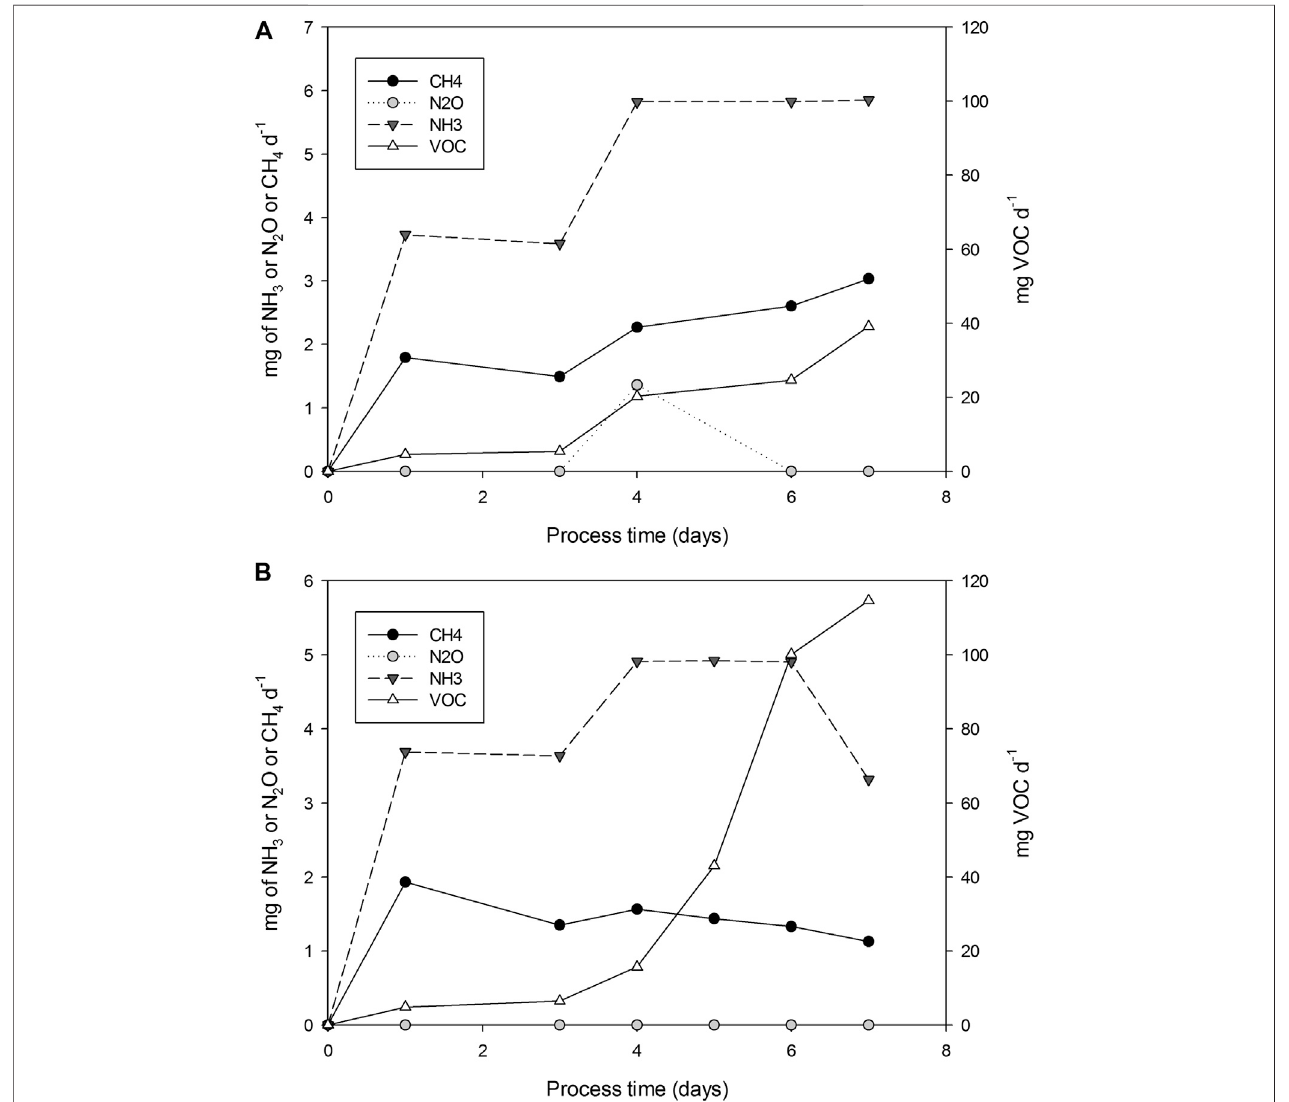
FIGURE 5 | Punctual emissions (mg d − 1 ) of CH 4 , VOC, NH 3 and N 2 O for experiments R22 replicates 1 and 2.